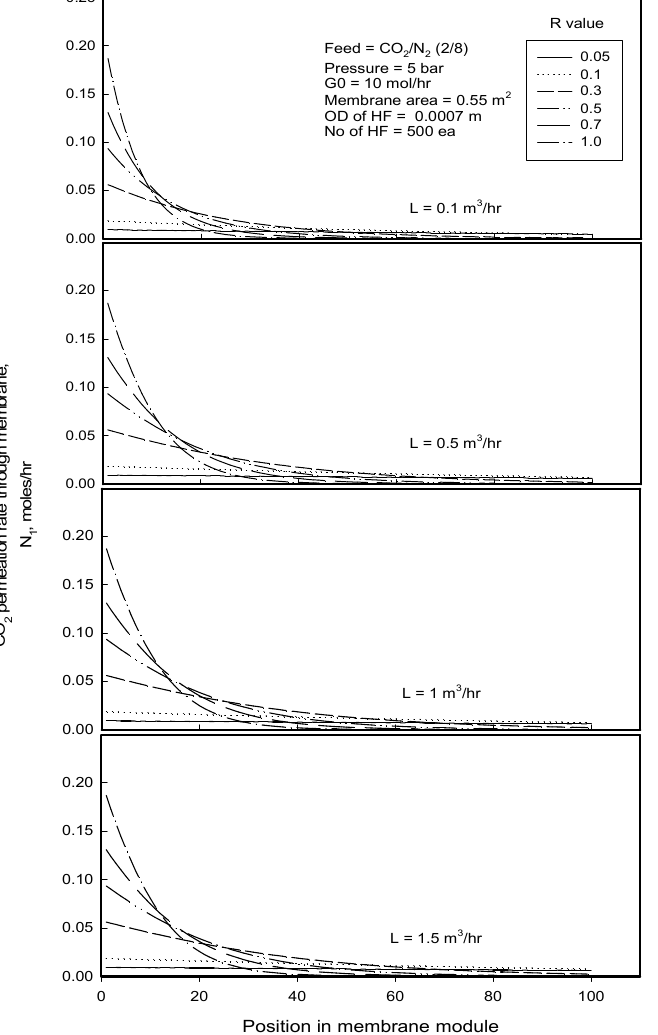
Figure 8. CO 2 permeation rate simulated with the position of membrane module in gassing process for the separation of CO 2 /N 2 mixture at different liquid flow rates and R-values.